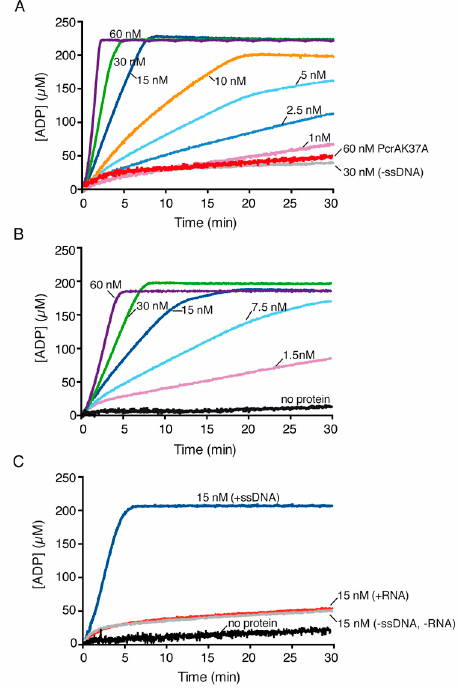
Figure 4. PcrA preferentially hydrolyzes ATP in the presence of ssDNA. PcrA (1–60 nM) was incubated with or without the indicated ssDNA (cssDNA ( A )), poly(dT) ( B ) or RNA ( C ) at 10 µ M (in nts) in buffer E containing 5 mM ATP, and the ATPase activity was measured (30 min, 37 °C). The red line is the ATPase assay of the PcrA K37A mutant variant, the grey line is the control without ssDNA ( A ) and the black line denotes the control reaction corresponding to the ATPase assay in the absence of any protein ( B , C ). Representative graphs are shown here, and the determined K cat is shown in Table S1.